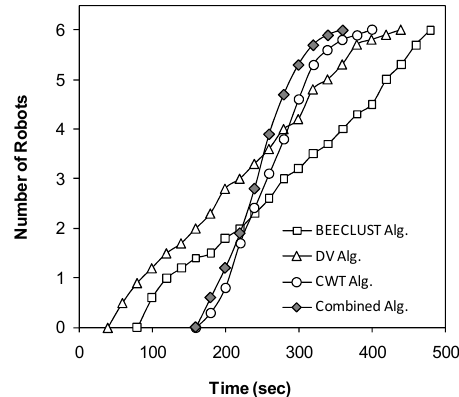
Fig. 16. Average number of the aggregated robots after changing lamp position for different algorithms as a function of